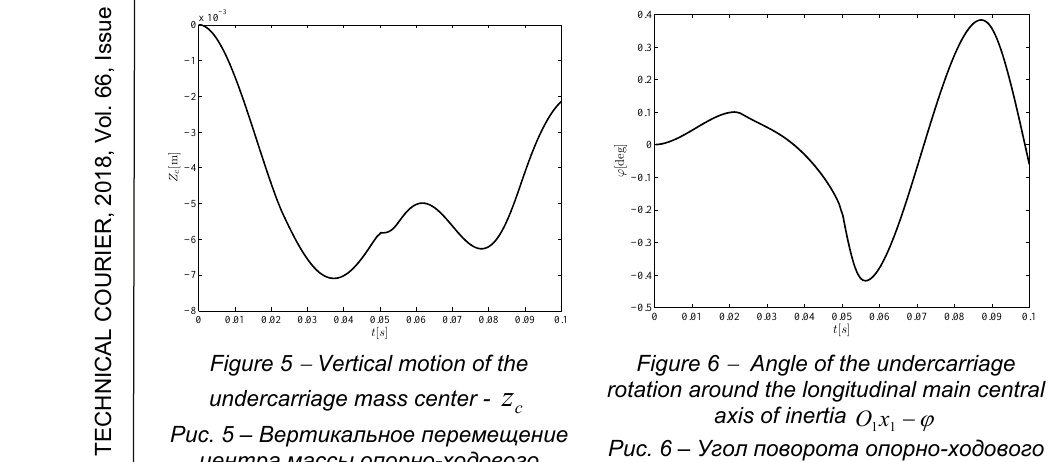
Figure 6  Angle of the undercarriage rotation around the longitudinal main central z c